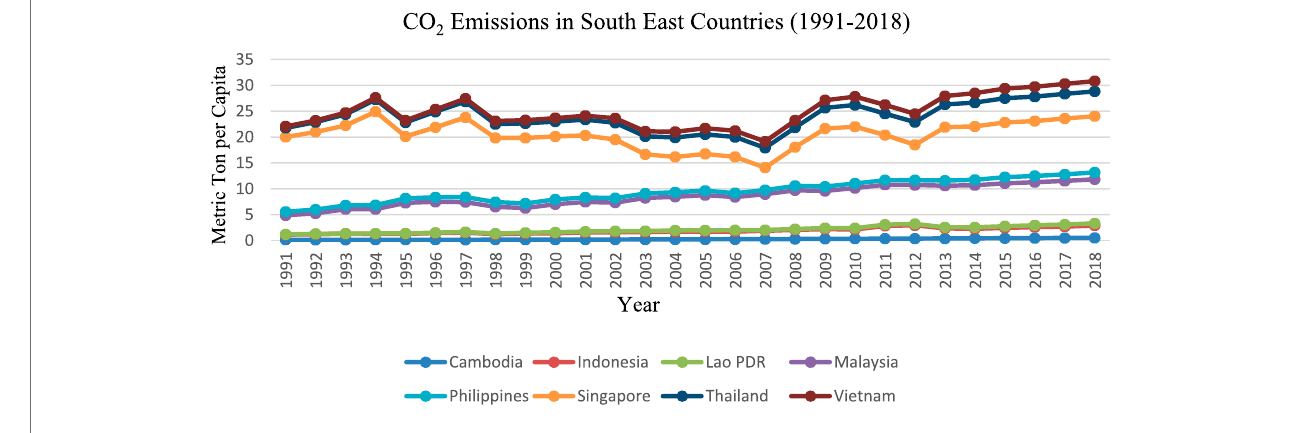
FIGURE 5 | CO 2 emission in Southeast Asian countries.